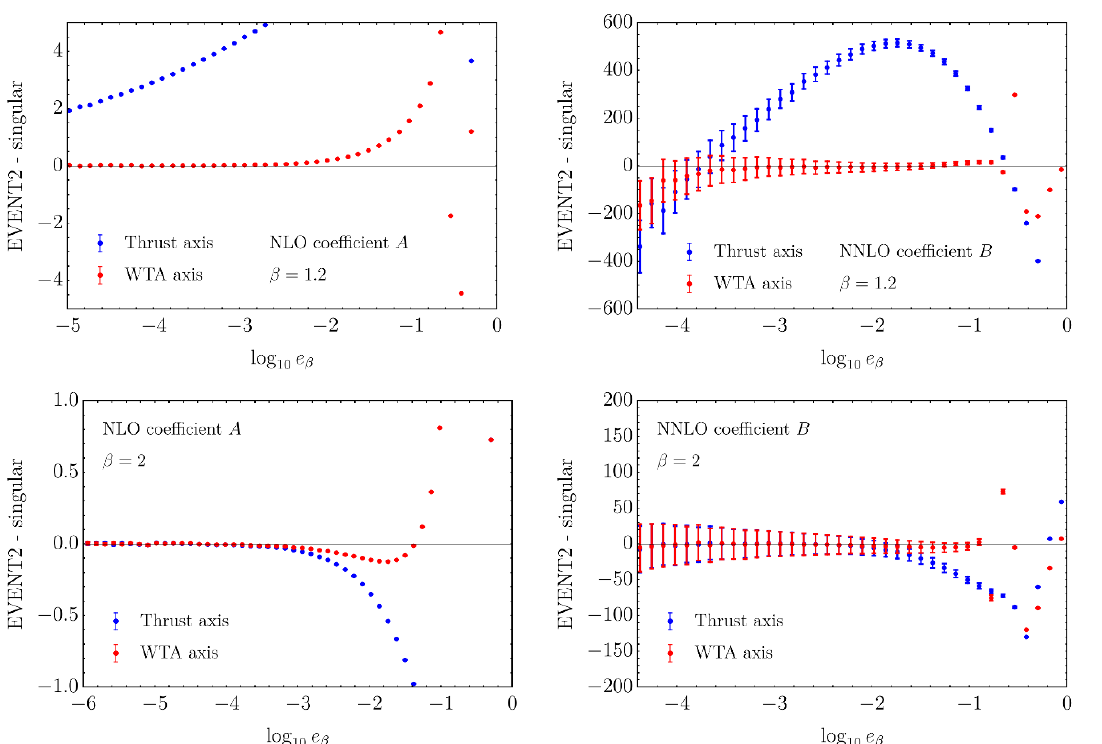
Figure 10 . Di(cid:11)erence between the NLO and NNLO terms for the single angularity cross section calculated by Event2 and our singular results. For (cid:12) = 1 : 2 with the thrust axis, the absence of a plateau is due to recoil